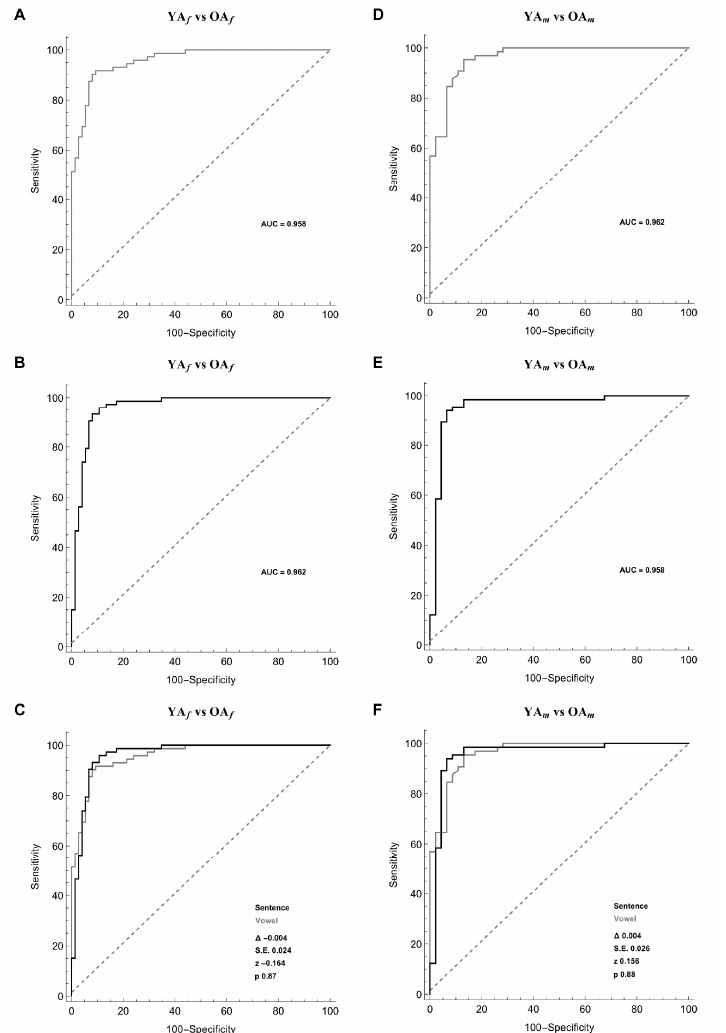
Figure 3. Receiver operating characteristic (ROC) curves used to differentiate female younger adults (YA f ) and female older adults (OA f ) (left column, panels ( A – C )) and male younger adults (YA m ) and male older adults (OA m ) (right column, panels ( D – F )) during the sustained emission of a vowel (grey line) (panels ( A , D )), the sentence (black line) (panels ( B , E )), and the comparison between the vowel and the sentence (panels ( C , F )).